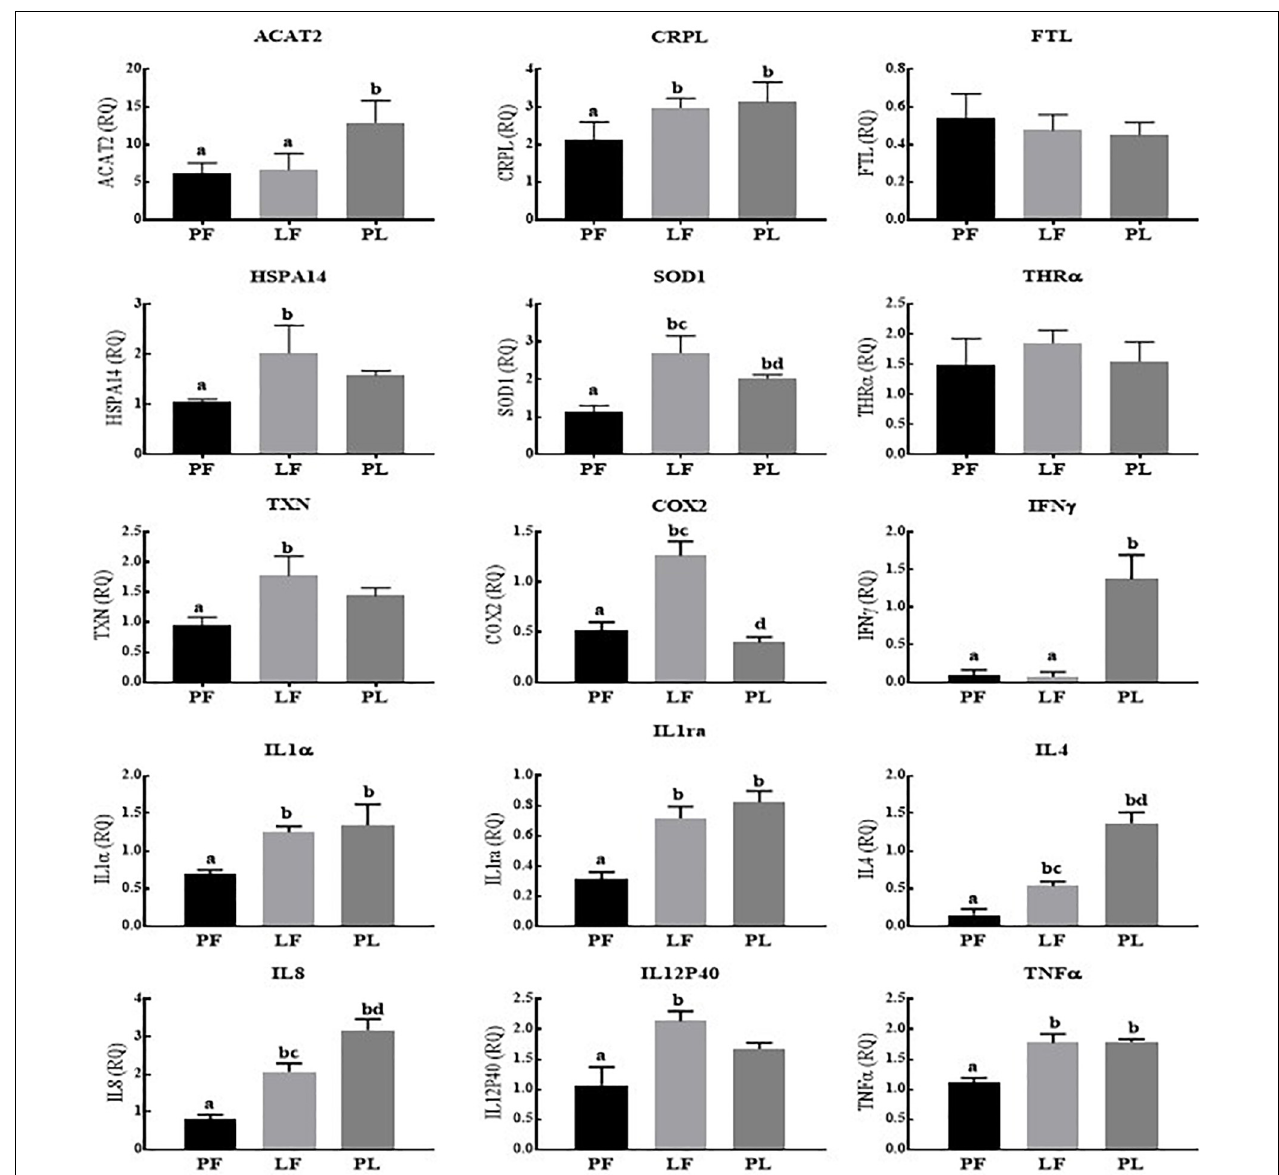
FIGURE 4 | Yangtze finless porpoises (YFPs) living in the Tian-E-Zhou Oxbow across the reproductive status. Each parameter followed by an alternate letter was significantly different at P ≤ 0.05. PF, Pregnant female; LF, Lactating female; PL, Pregnant plus lactating female.